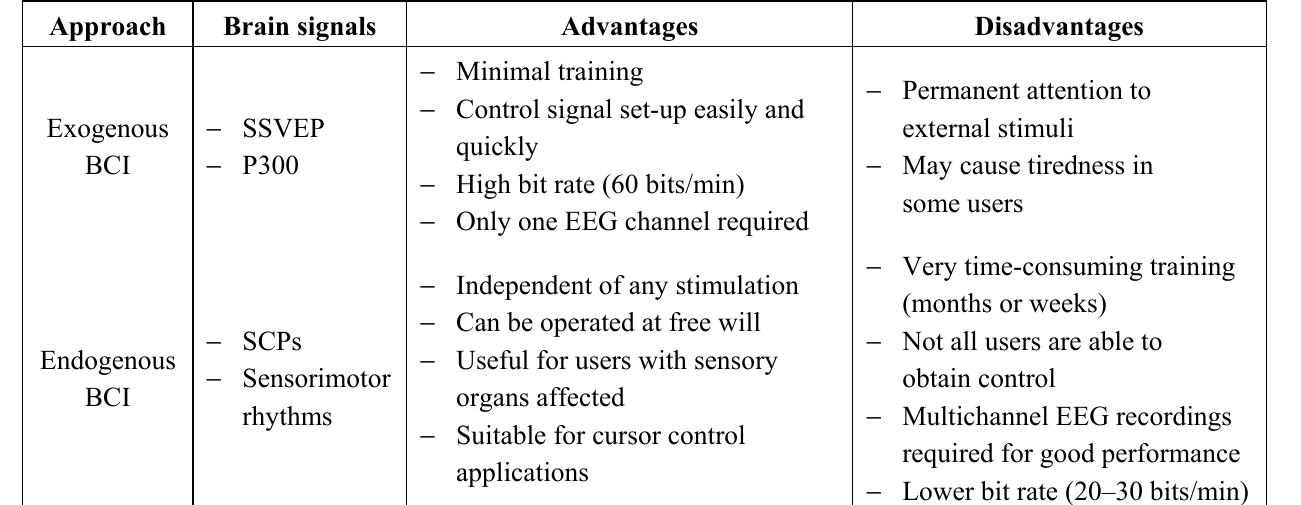
Table 4. Main differences between exogenous and endogenous BCI.